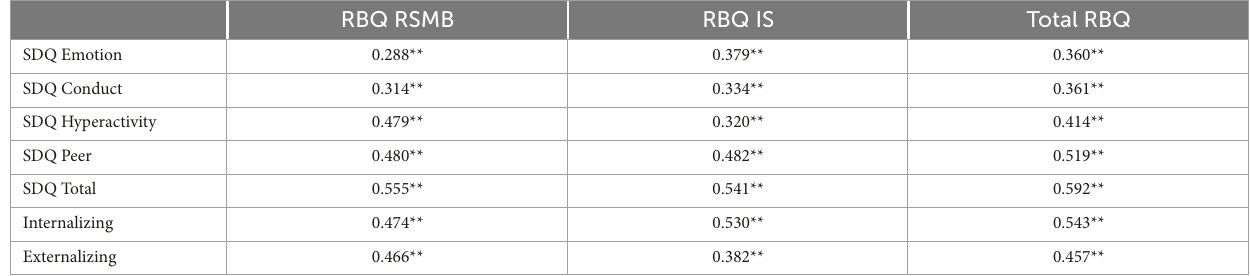
TABLE 7 Correlations between RBQ-2 and SDQ measures.